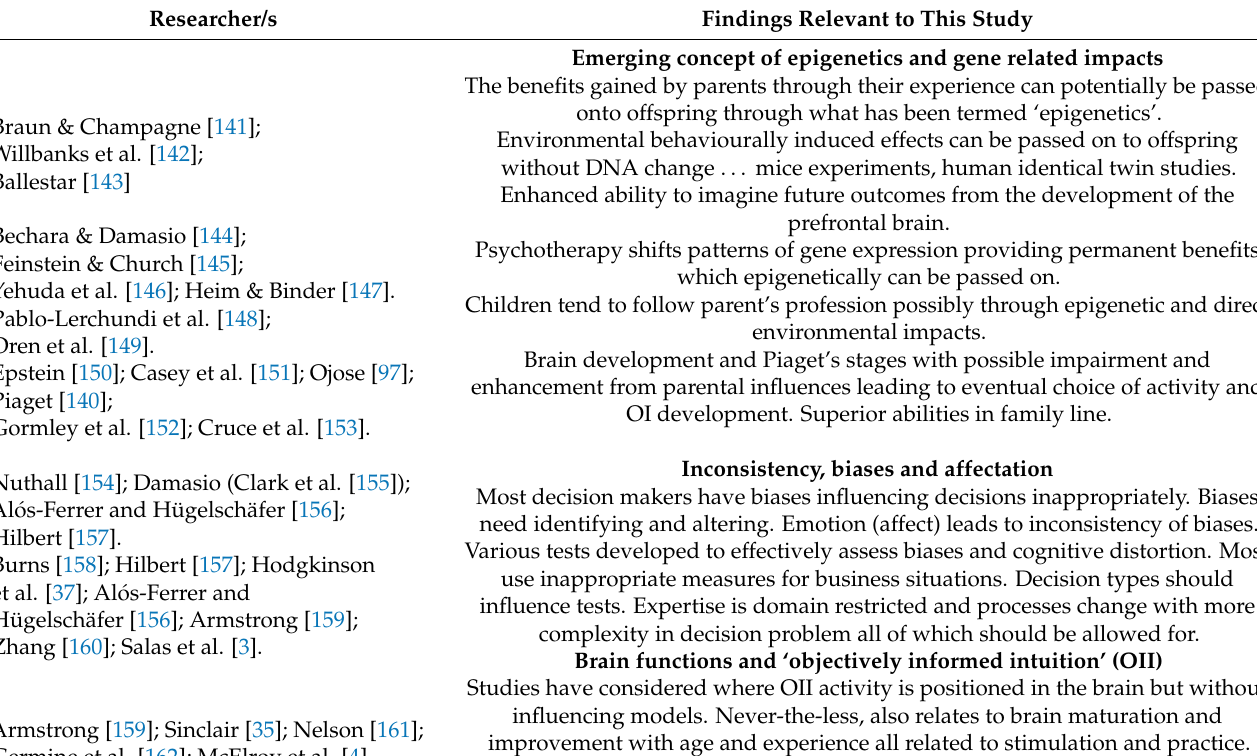
Table 7. Summary of research on the possible refinement of the parameters and their values in the model of OII (covering . . . Gene expression and related impacts; Inconsistency, biases and affectation; Brain functions and ‘objectively informed